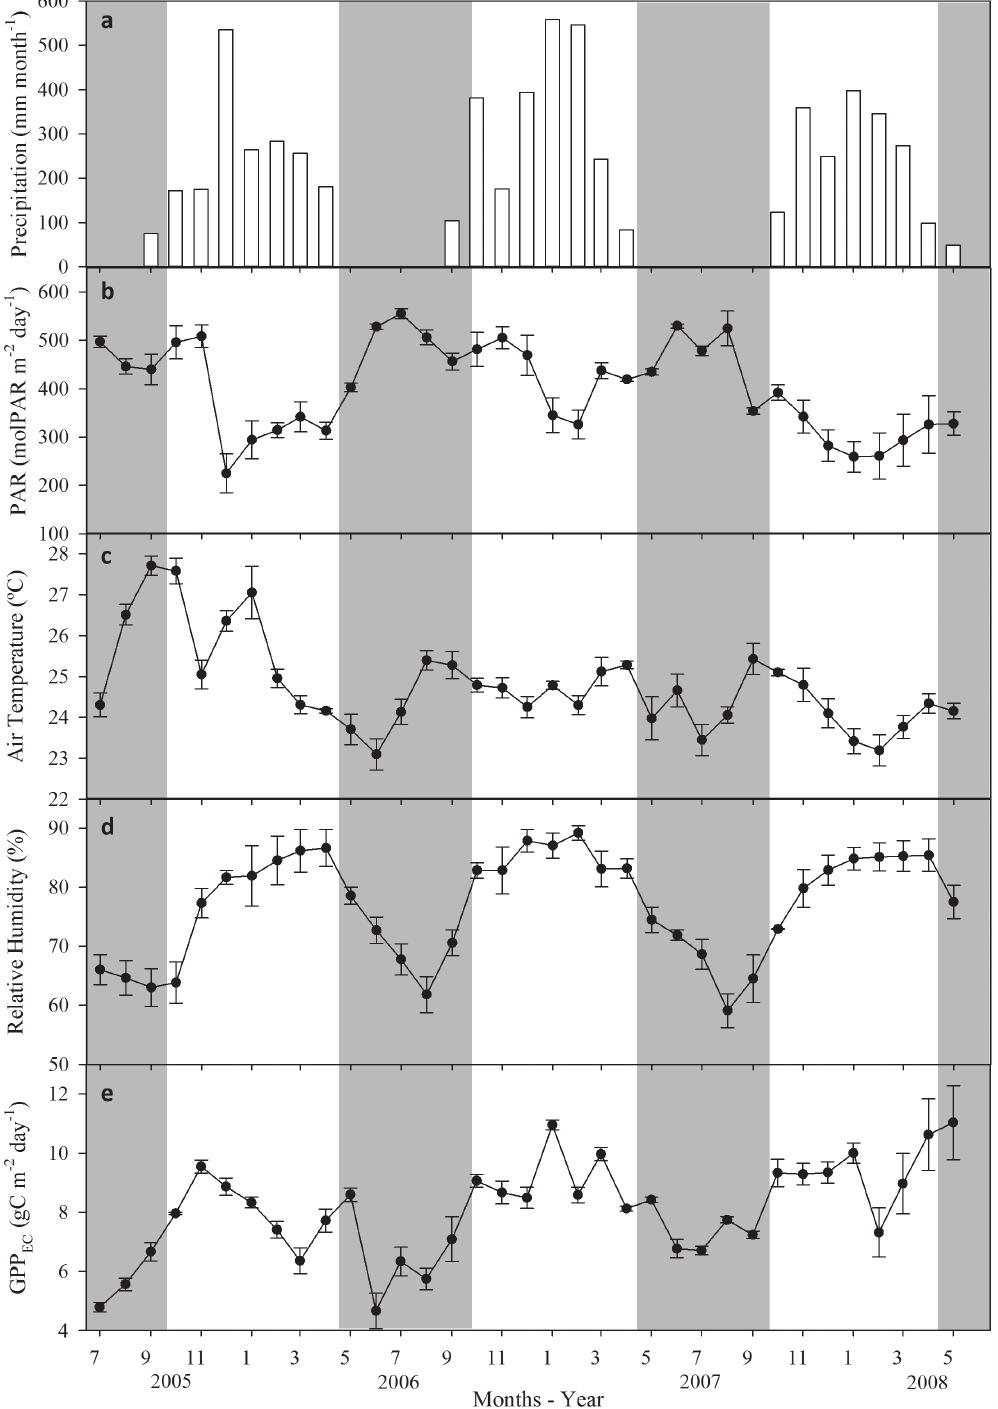
Fig. 2 - Monthly precipitation ( a ), monthly average (± standard deviation) of photosynthetic active radiation (PAR) ( b ), air temperature ( c ), relative humidity ( d ) and gross primary production measured by the eddy covariance (GPP ) ( e ) in the Amazon-Cerrado transitional forest from July 2005 to June 2008. The gray vertical EC column represents the dry